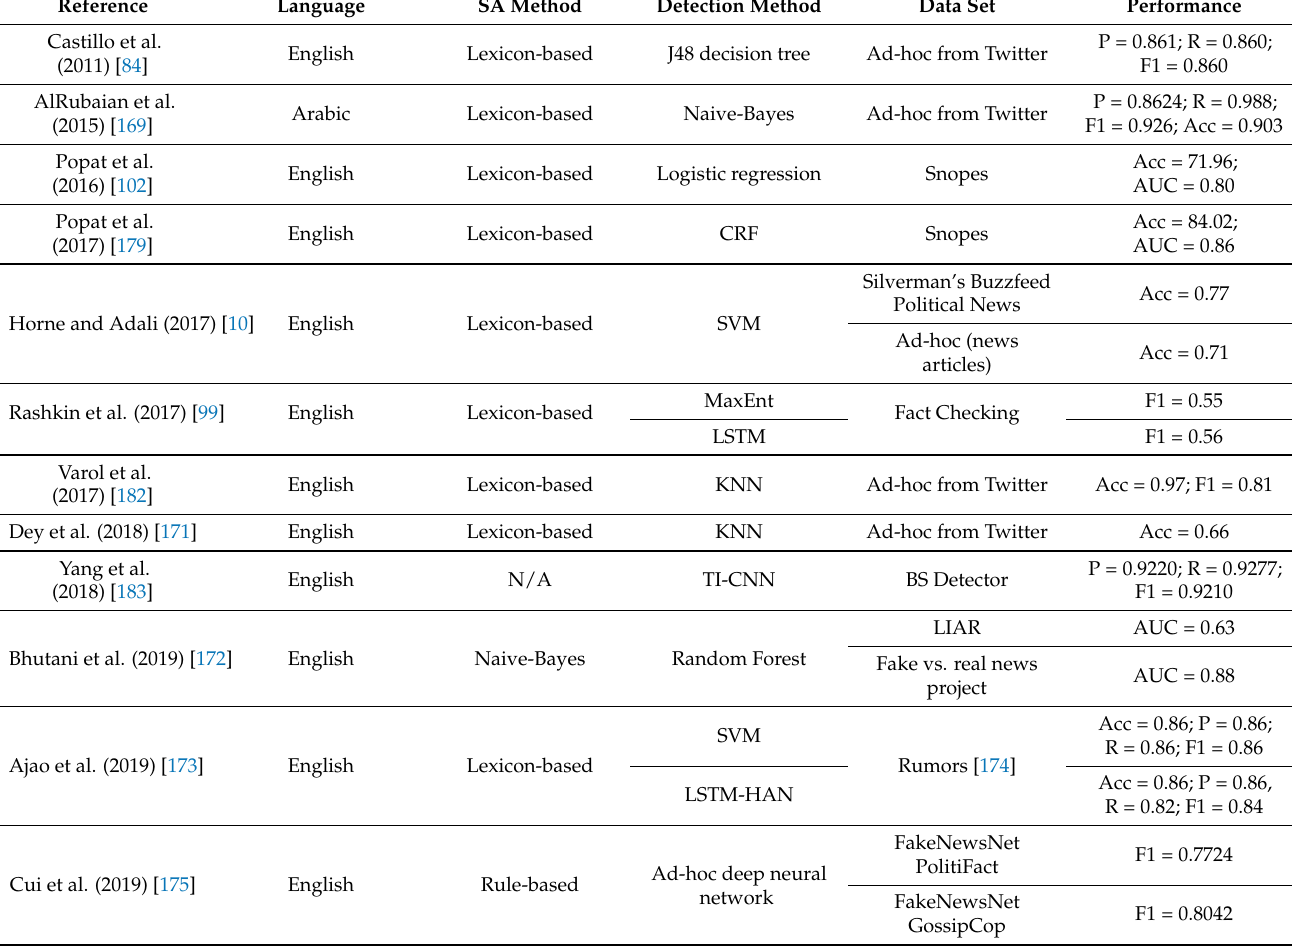
Table 2. Main characteristics of fake news detection systems using SA: systems that provide quantitative performance results on the task (part 1 of